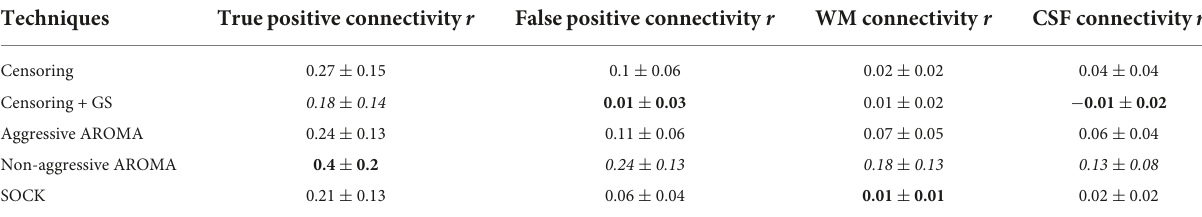
TABLE 3 Identifiability sub-scores of